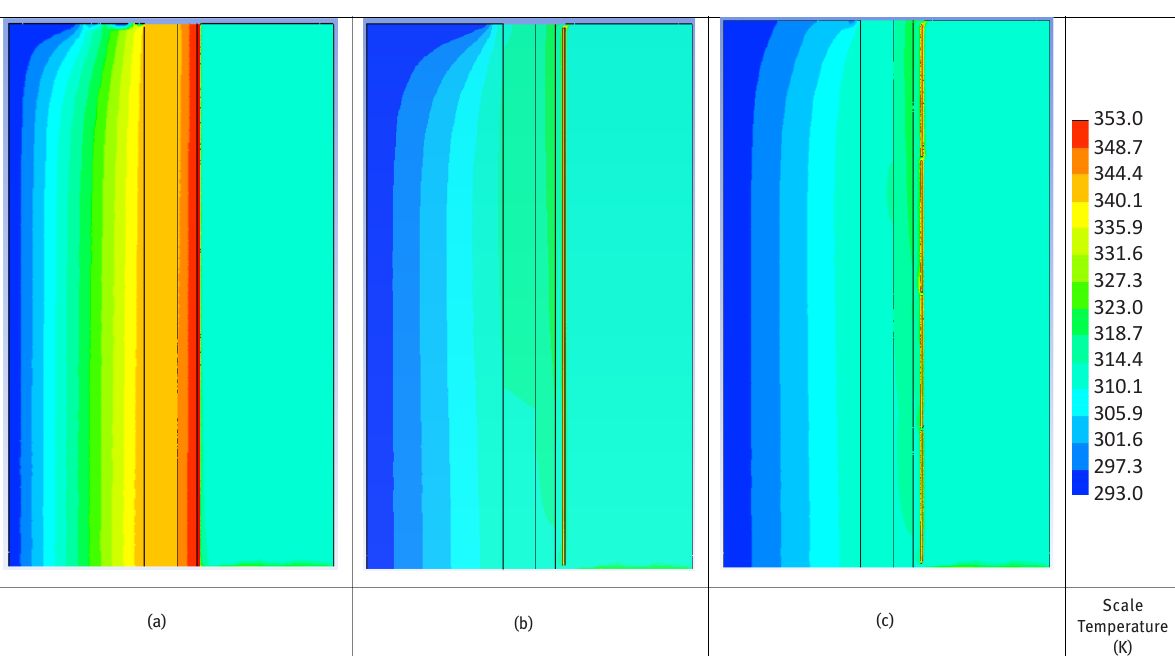
Figure 5: Numerical model of the closed-joint ventilated facade.